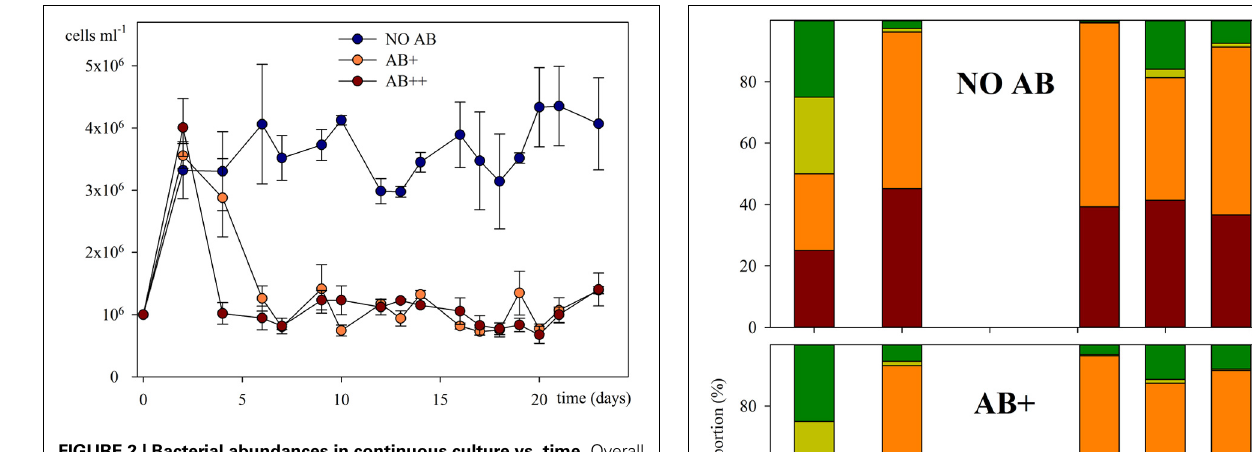
RE-GROWTH OF ADAPTED